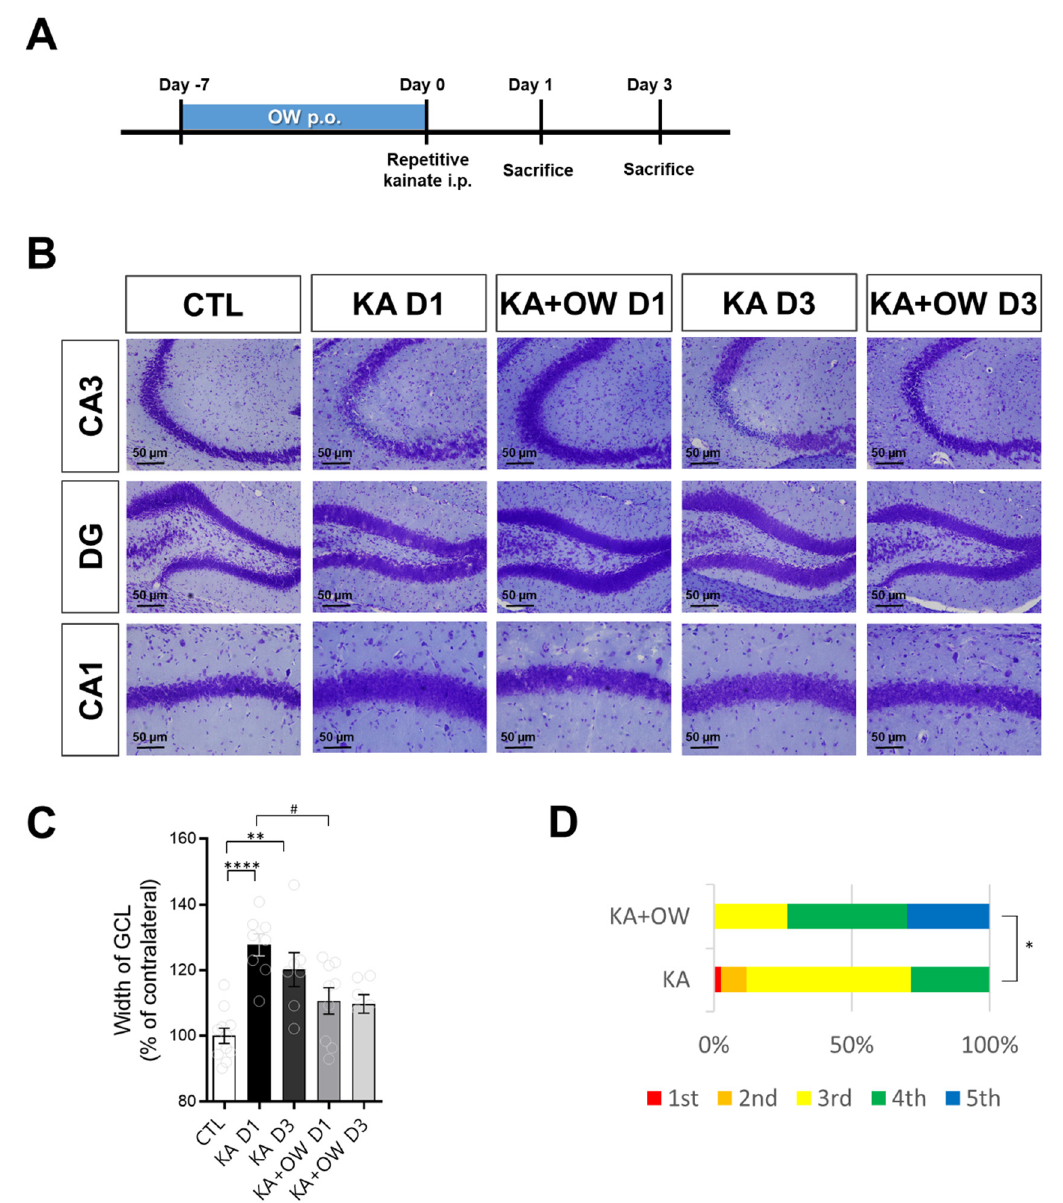
Figure 3. Effect of OW in the kainate mouse model. ( A ) The experiment was performed after administration of OW for 1 week before kainite modeling. ( B ) Hippocampal cell morphology was examined with cresyl violet staining. ( C ) Temporal changes in the width of granular cell layer (GCL) in CA3 were examined. Error bars denote SEM (one-way ANOVA, Newman–Keuls post hoc test: CTL vs. KA D1, **** p < 0.0001; CTL vs. KA D3, ** p < 0.01; KA D1 vs. KA + OW D1, # p < 0.05). ( D ) The distribution confirmed the sensitivity to kainic acid (KA) in each mouse (number of injections of KA that provoke seizures). Error bars denote SEM (one-way ANOVA, Newman–Keuls post hoc test: * p < 0.05). CA, cornu ammonis; DG, dentate gyrus.